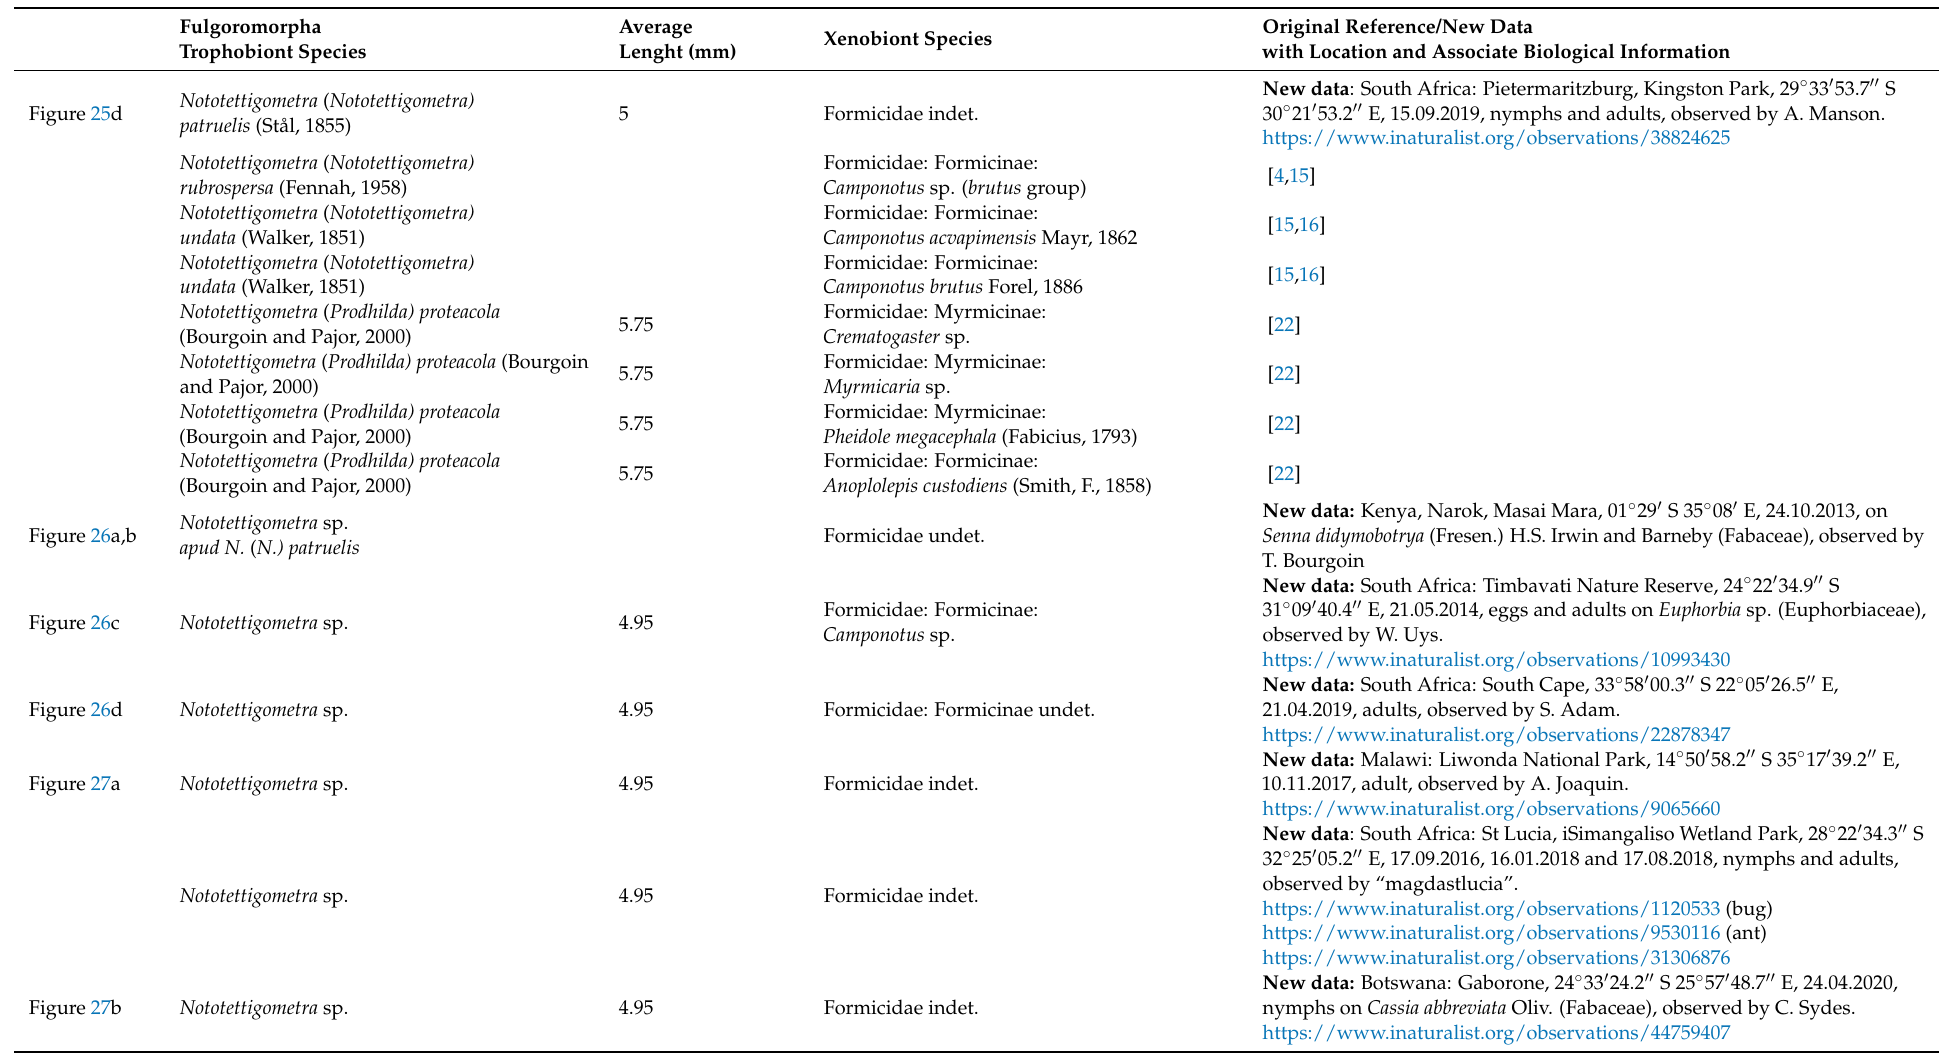
Figure 27b Nototettigometra sp. 4.95 Formicidae